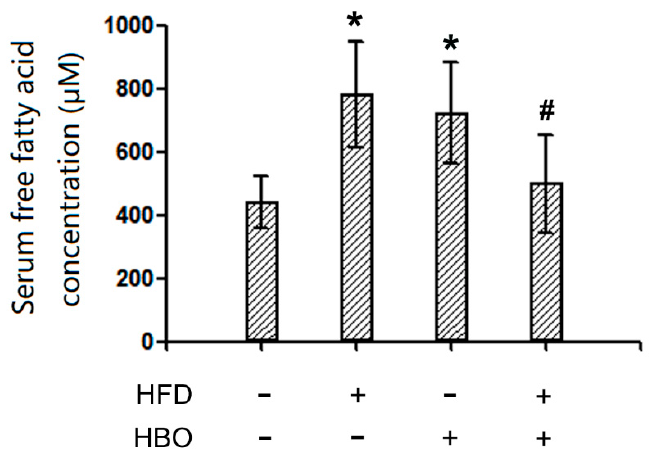
Figure 6. Serum free fatty acid (FFA) levels. Serum FFA levels were measured with a commercially available kit (BC0595, Solarbio, China). Three to five samples from independent animals were included in the tests. Error bars represent standard derivation. *: statistically different from control group animals ( p < 0.05). #: statistically different from HFD group animals ( p < 0.05).